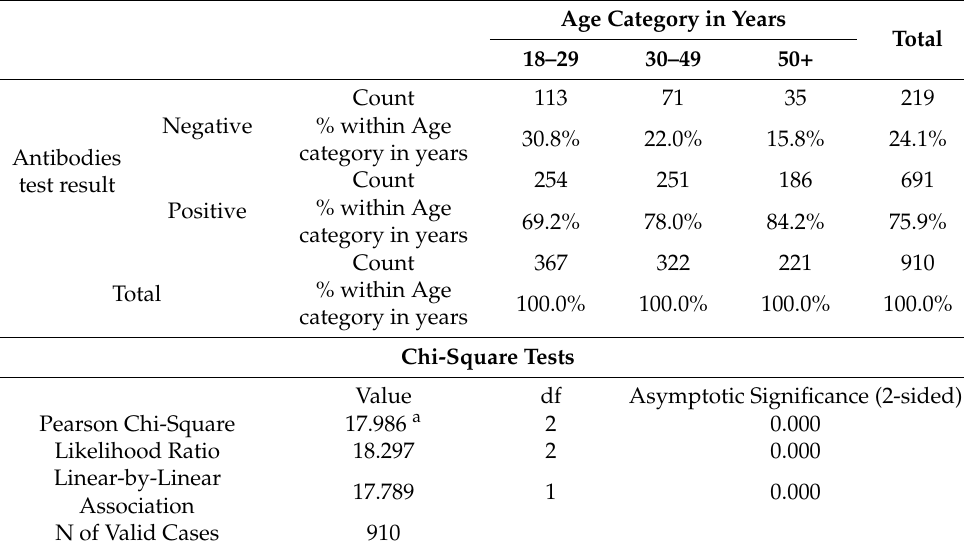
Table 5. Antibodies test results by age